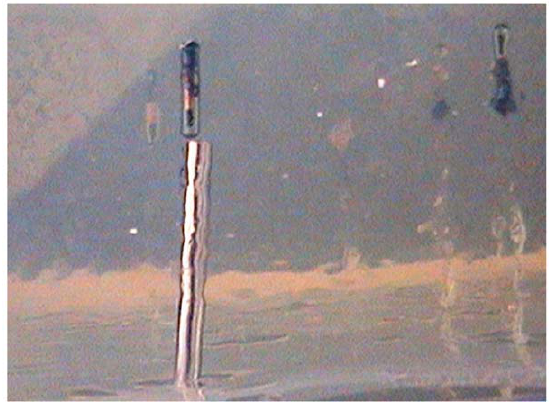
Figure 2. Penetration of Passive Integrated Transponder tags (PIT) into a gelatin block after being injected from a prototype dart. A probe was inserted into the path the PIT followed and length was measured to determine the depth that PIT penetrated the gelatin block. The prototype dart with the shortest depth of penetration was considered most suitable for remote darting into